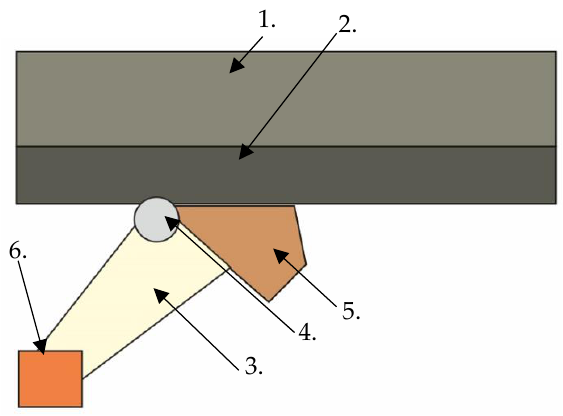
Figure 13. Rear underrun protective device RUPD-AB. 1—Part of the vehicle body; 2—Vehicle frame; 3—Support member; 4—Joint connecting support member with vehicle frame; 5—Energy-absorbing element; 6—RUPD guard bar.